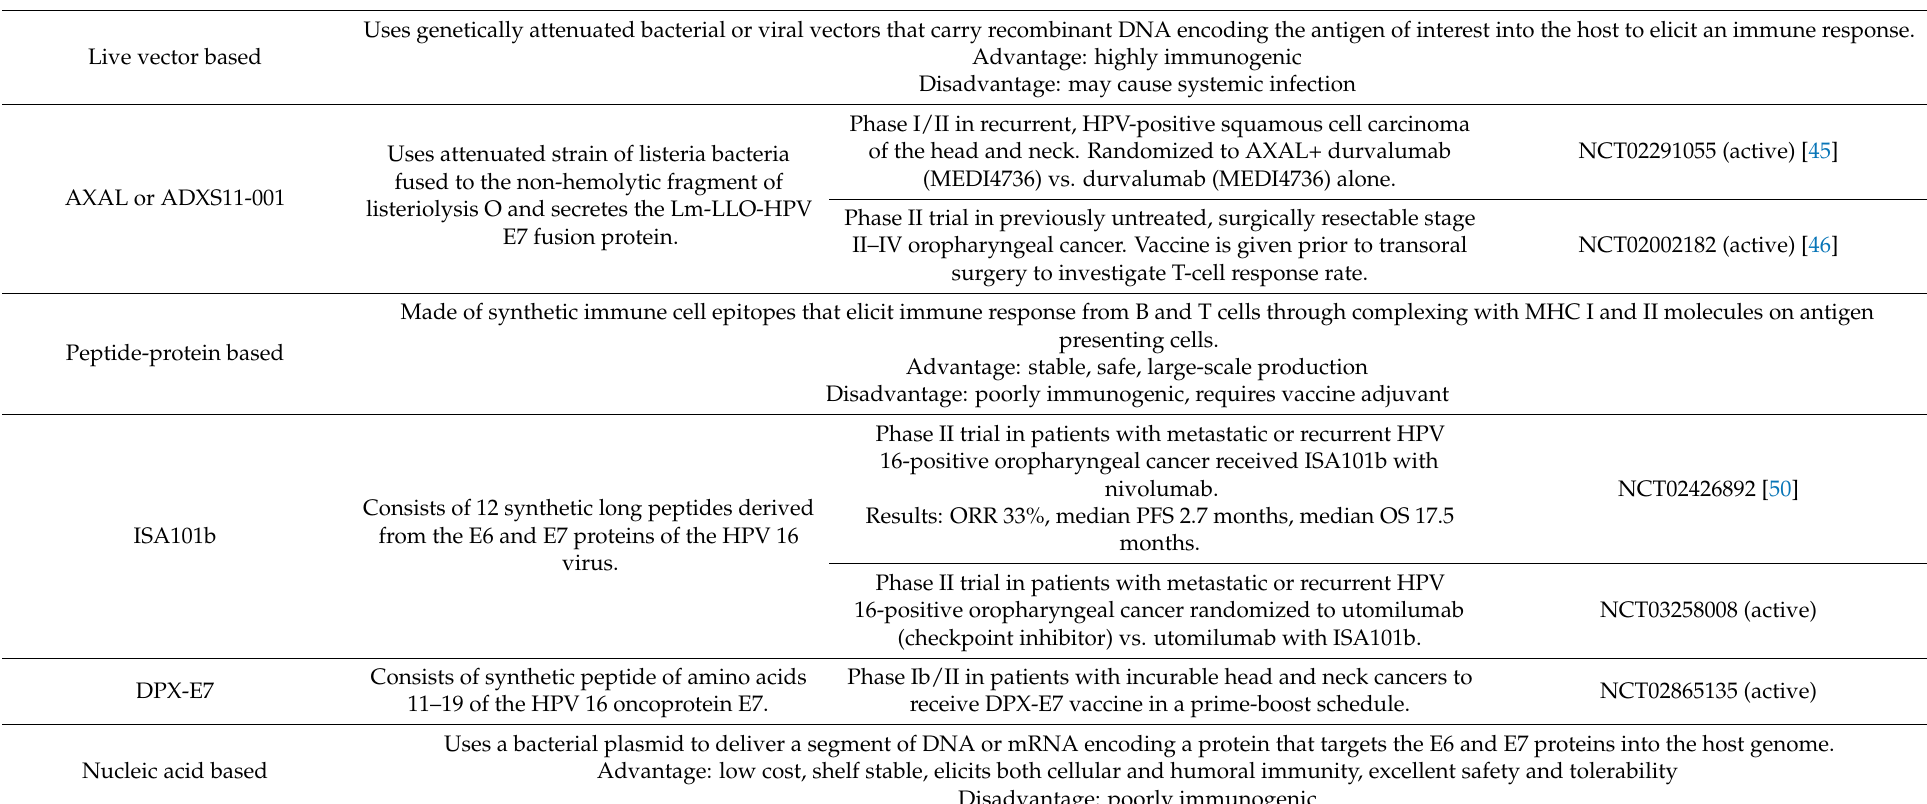
Table 2. Therapeutic HPV vaccines under development in trials for oropharyngeal/head and neck cancers.